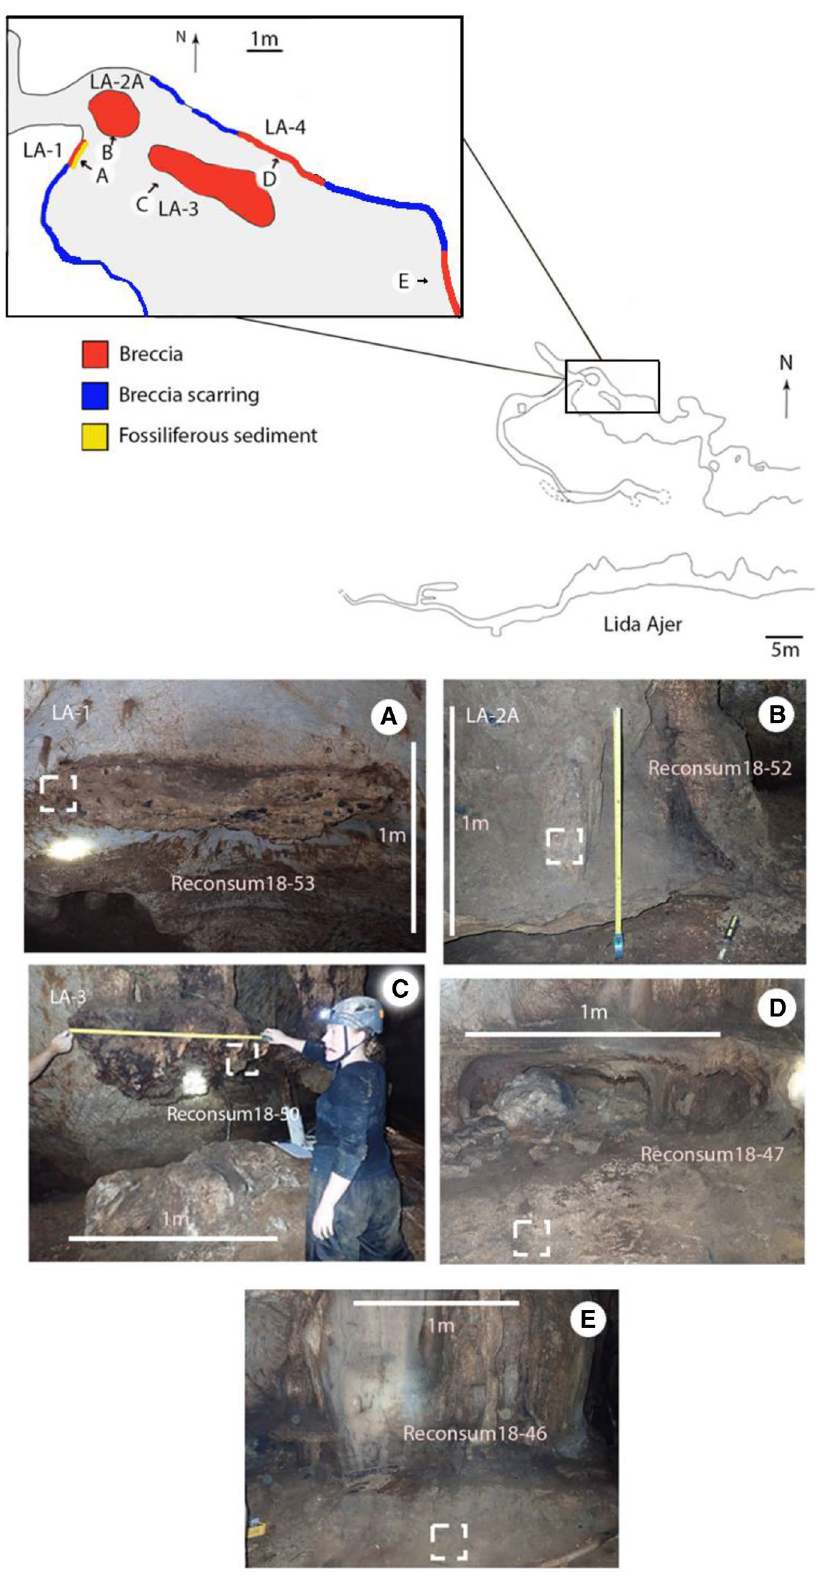
Figure 2. A scale profile map of Lida Ajer (above) and a scale plan map of Lida Ajer (inset) with a colour scale section highlighting the key breccia and fossiliferous sediment sites. (below) ( A – E ): Photographs of the key breccia sites in Lida Ajer, the white dashed box highlighting the exact extraction point of the samples. Arrows indicate the orientation of photographs A-E in relation to the inset scale profile map. ( C ) Co-author performing